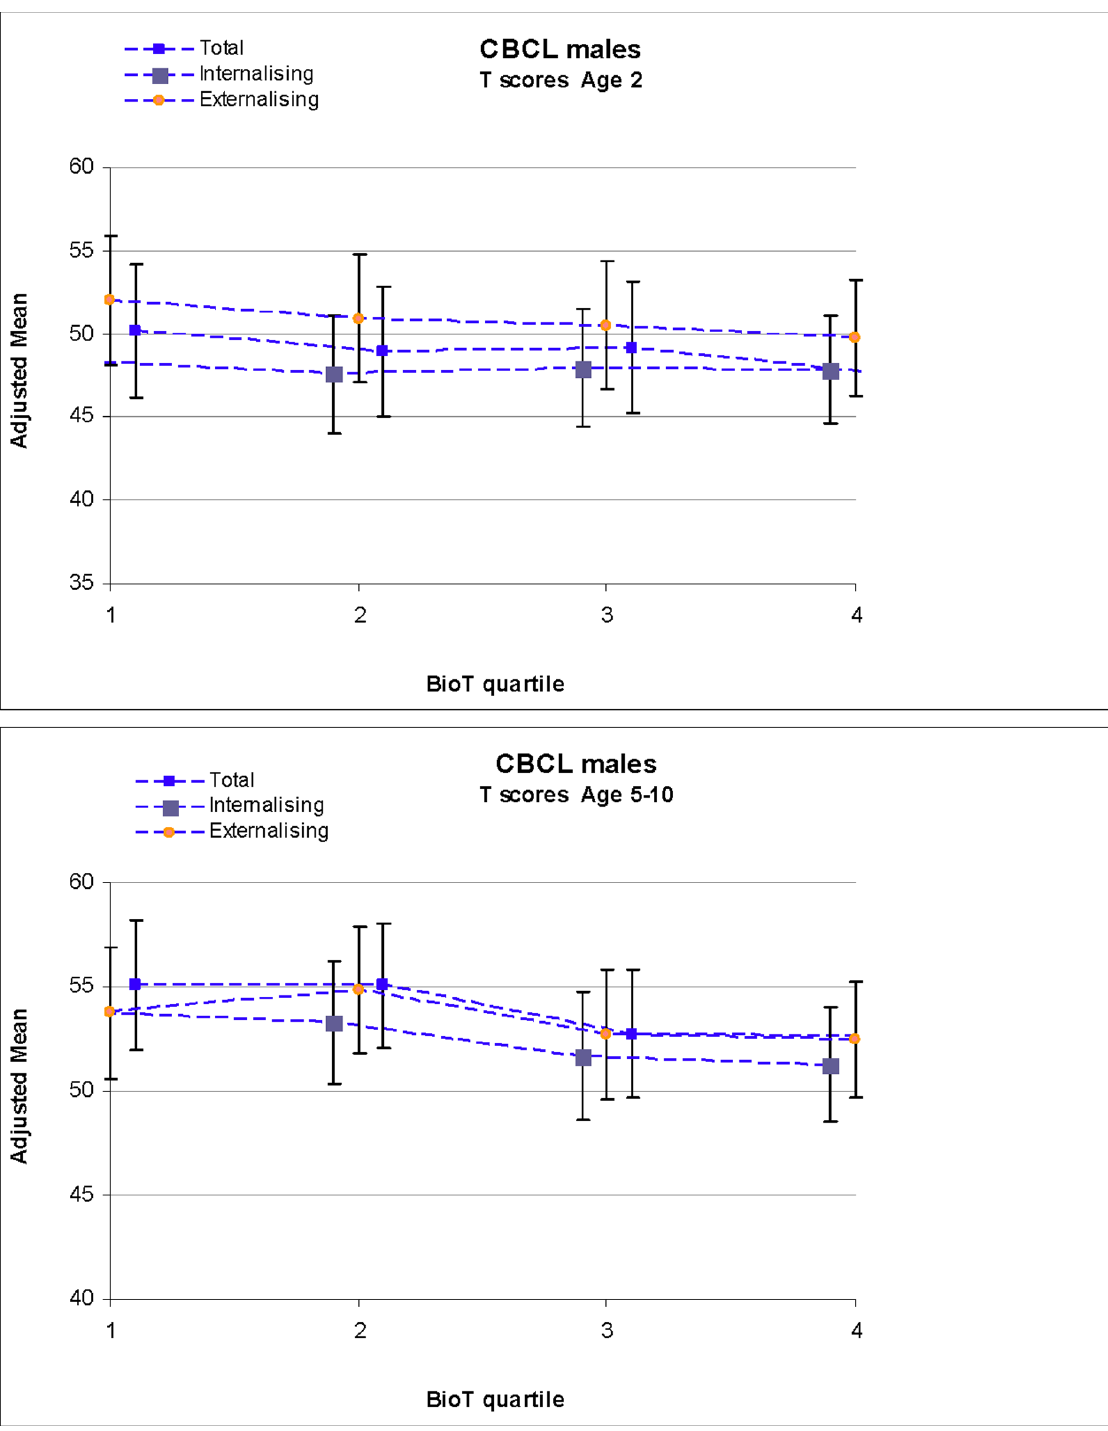
Figure 2. Mean CBCL total, internalizing and externalizing T-scores at age 2 and age 5–10 by BioT quartile for males. doi:10.1371/journal.pone.0059991.g002 aggression and attention problem raw scores (males) and withdrawn and social problem raw scores (females) [6,8].